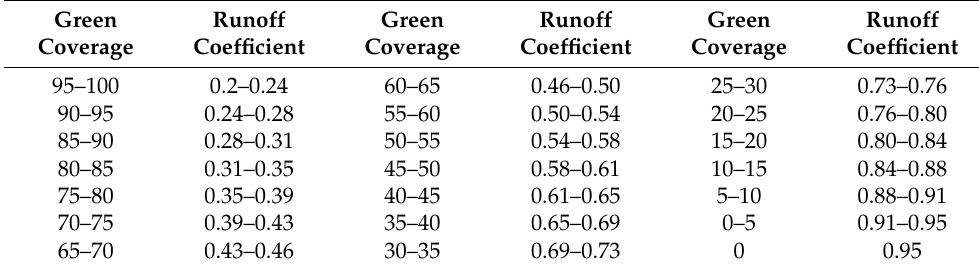
Table 1. Correspondence between comprehensive runoff coefficient and green